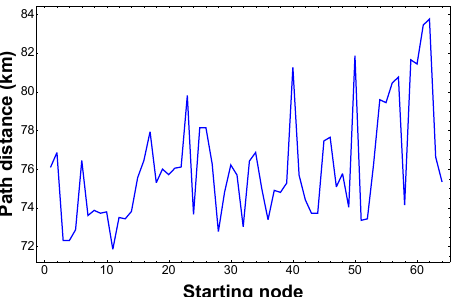
Figure 20. Path distances changing start node from the Veracruz-Boca del Rio